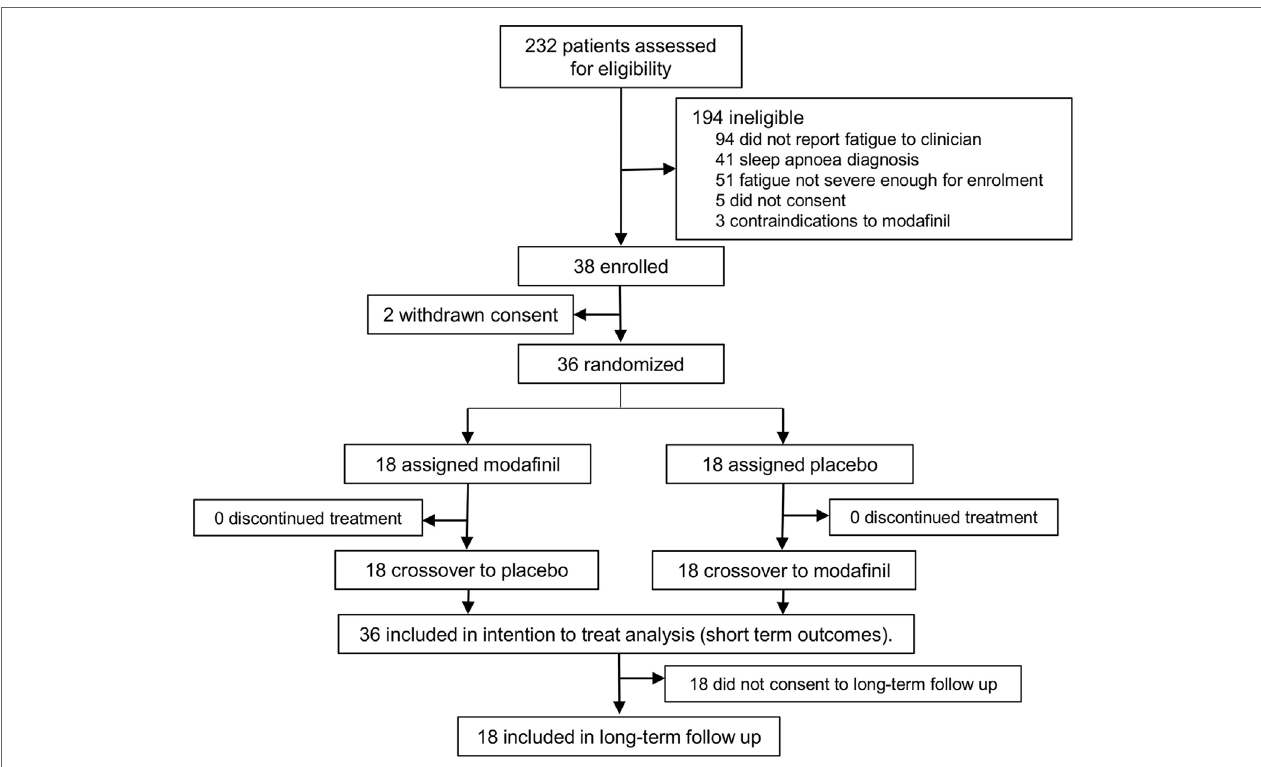
figUre 1 | Patient flow for the modafinil in debilitating fatigue after stroke trial and subsequent long-term sub study. Patients were screened for severe fatigue and then randomized to either modafinil or placebo for 6 weeks, followed by treatment crossover after a 1-week washout period. Patients were contacted by mail 12 months after the conclusion of the trial and invited to take part in the long-term sub study. Those who consented to this sub study were interviewed and assessed for long-term